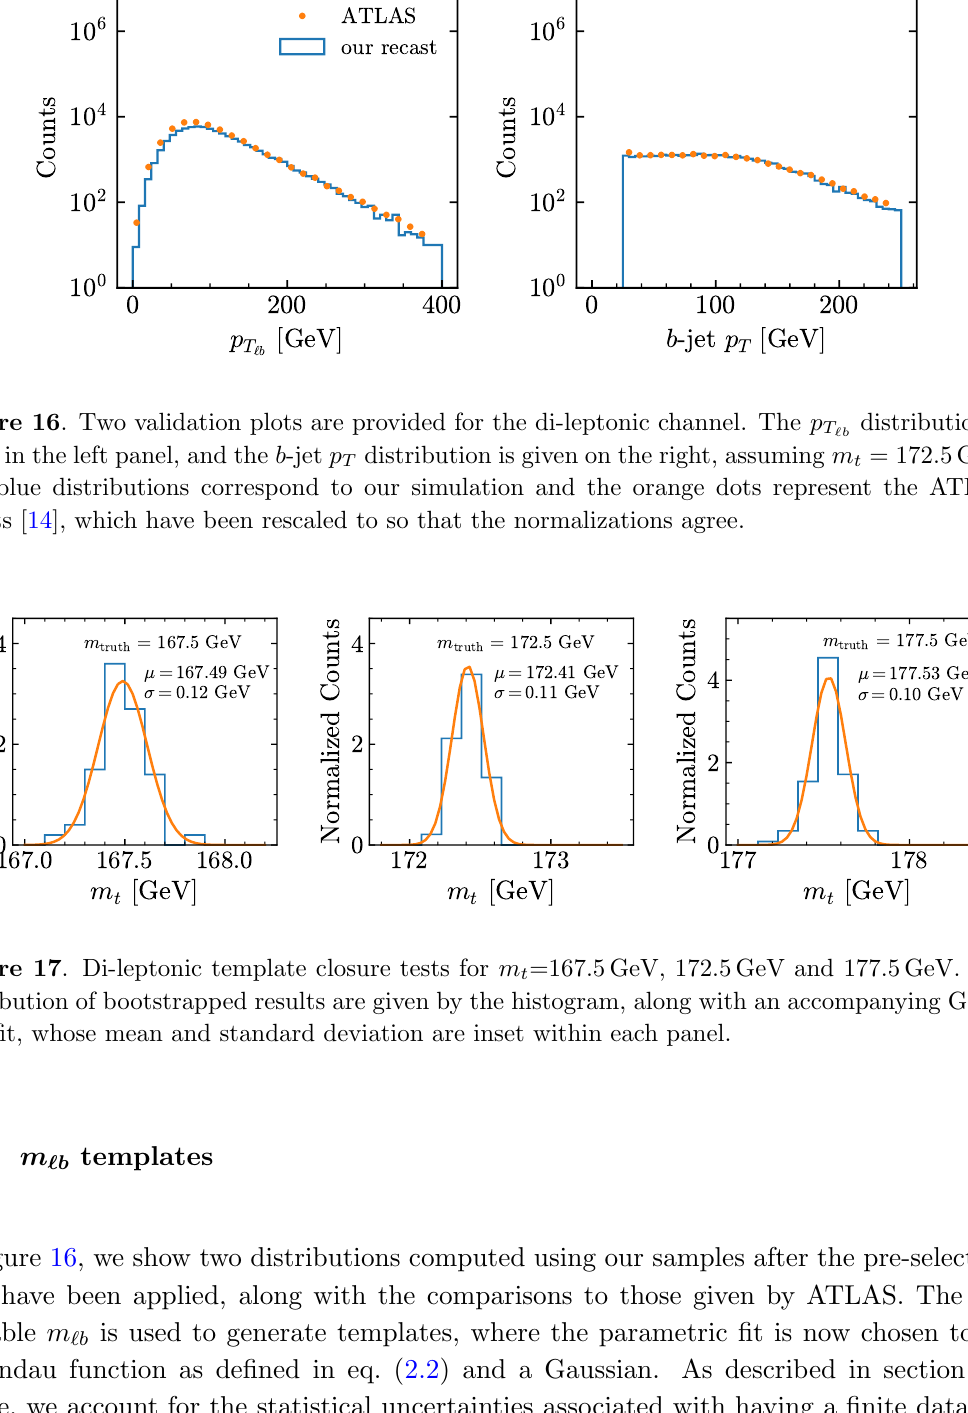
distribution is ‘b